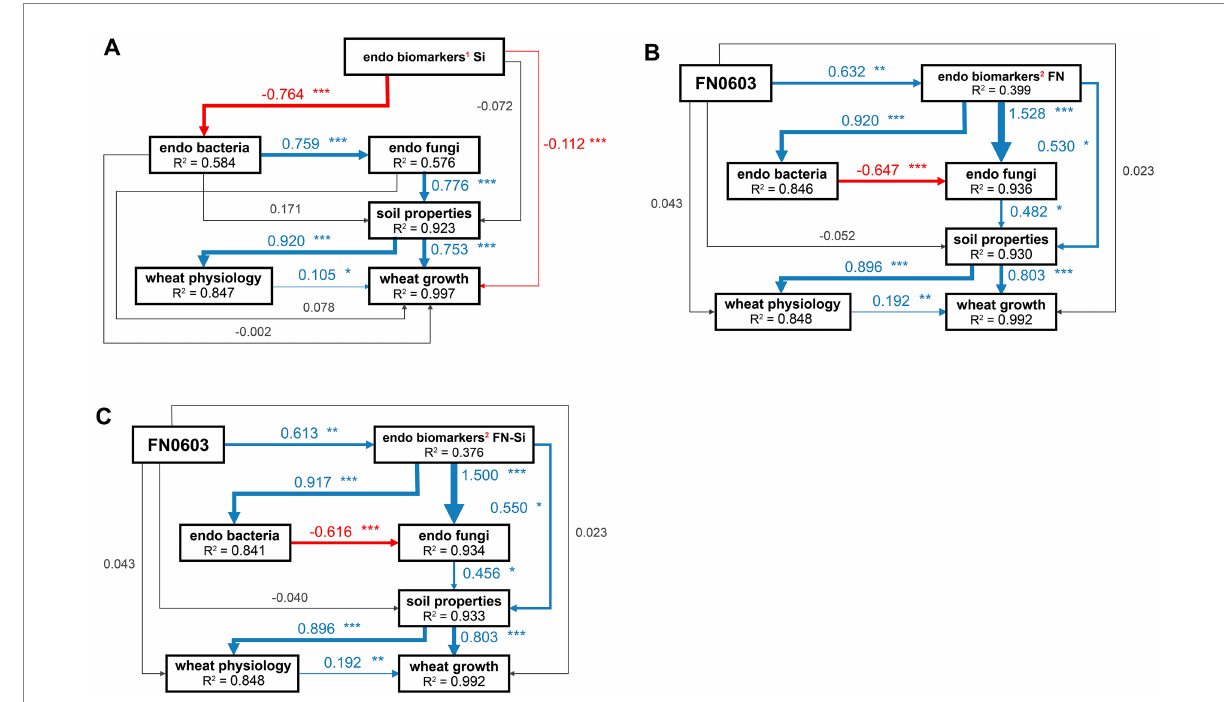
FIGURE 7 Structural equation model (SEM) analyzing the directly and indirectly effect paths of (A) Si, (B) FN and (C) FN_Si on wheat growth through specific biomarkers, root endophytic microorganisms, soil properties, and wheat physiology. Numbers adjacent to each arrow are the standardized path coefficients. The width of each arrow is proportional to the strength of its corresponding path coefficient. R 2 denotes the proportion of variance explained. Blue and red arrows indicate positive and negative relationships, gray line indicate non-significant relationships, respectively. * Represents a significant difference (*** p < 0.001; ** p < 0.01; * p < 0.05), 1 represents not FN-specific biomarkers, 2 represents FN-specific